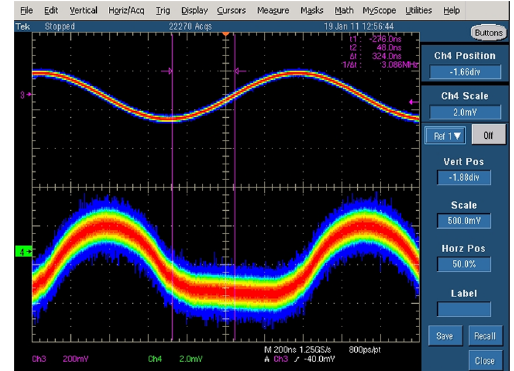
FIG. 6. Oscilloscope traces of the main rf (top) and beam pickup (bottom) for the uncooled beam. The time trace repre- sents roughly 1.5 rf periods. Note that the pickup sees no beam for about half of the machine cycle.